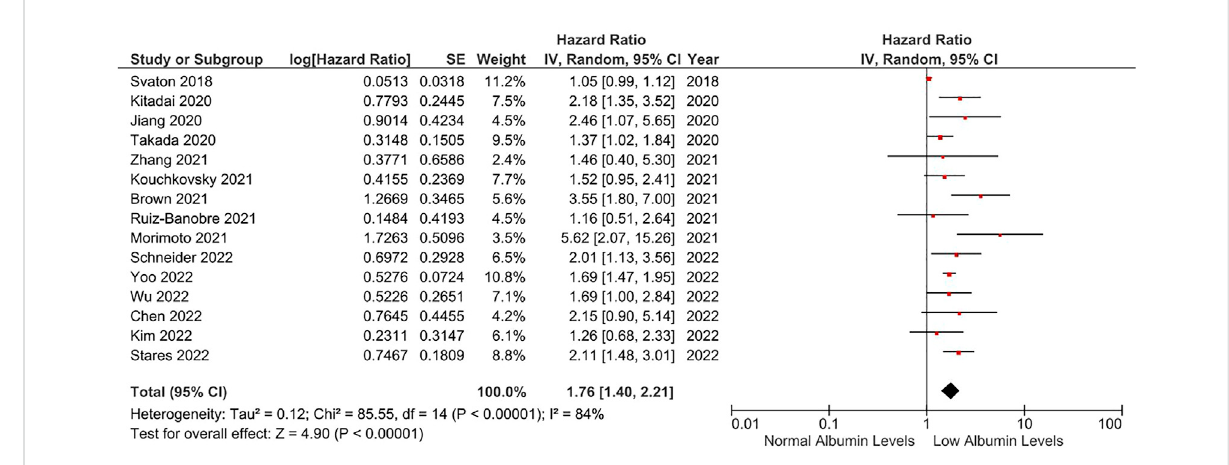
FIGURE 4 The association between albumin levels and PFS. Lines ( ○ ) indicate 95% CIs. Diamond ( ◆ ) indicates the pooled effect